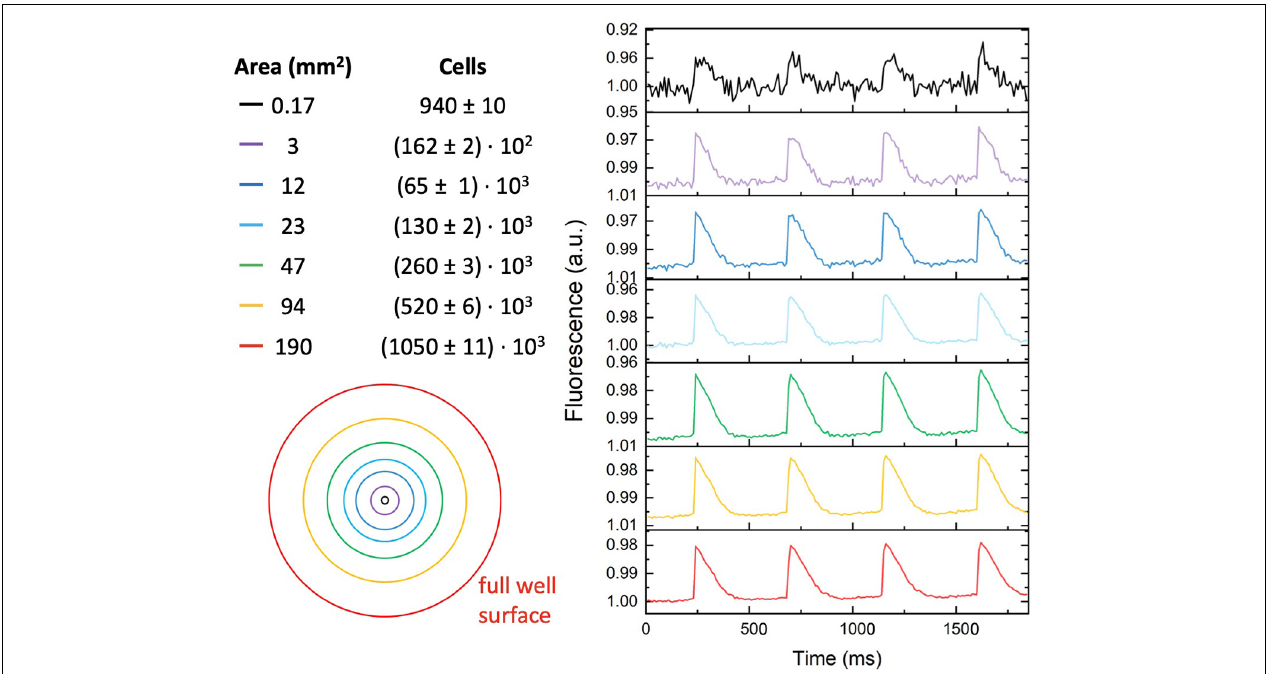
FIGURE 4 | Signal-to-noise ratio versus detection area. Representative optical recording of optogenetically induced APs collected from different-sized surface areas (2 Hz stimulation frequency with blue light pulses duration of 30 ms). Reduction of the detection area from the whole well area ( ≈ 190 mm 2 ) to 0.17 mm 2 , reduced the signal-to-noise ratio from ≈ 600 to ≈ 2. The estimated number of cells present in the different-sized detected area is indicated in the right